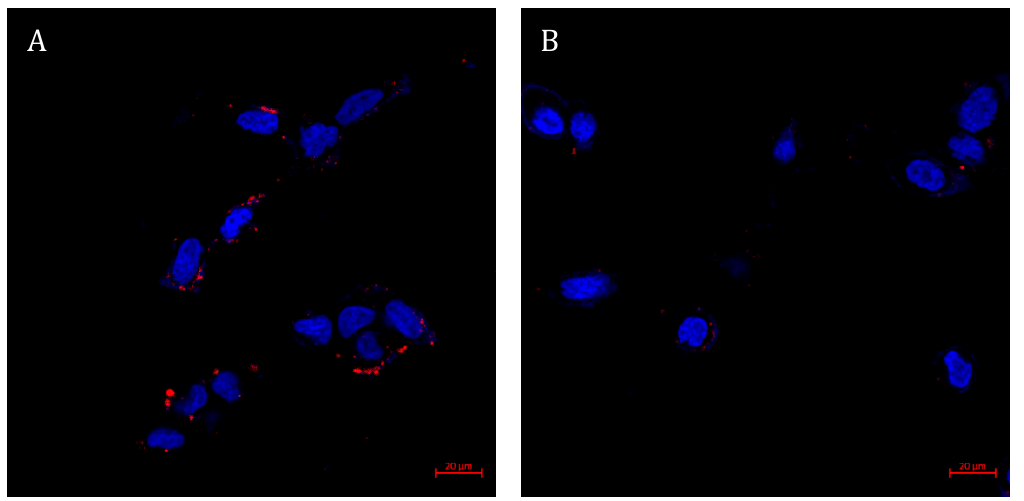
Figure 11. Characterization of active internalization of targeted NPs by LNCaP cells. Confocal laser microscopy images of LNCaP cells, following 1 h incubation with targeted NPs labeled with Cy7 (samples were diluted 1:400 (v/v) in FBS-free medium) at two different temperatures: ( A ) 37 °C; ( B ) 4 °C. Nuclear DNA staining achieved with Hoechst 33342 (1 μ g/mL) is marked in blue, whereas NPs labeled with Cy7 are marked in red. Scale bars denote 20 μ m.